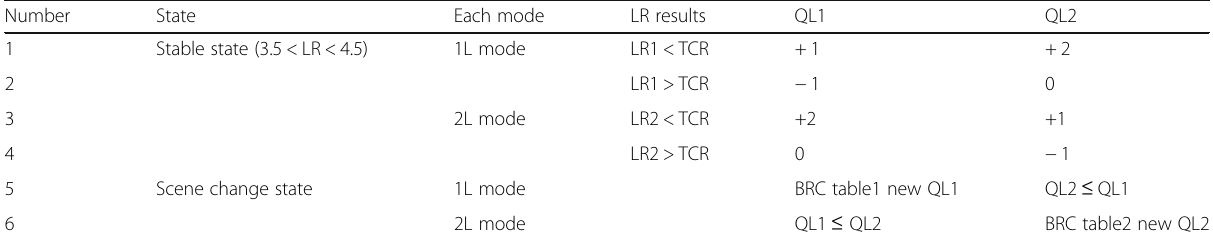
Table 2 Adjustment cases of the QLD process for 1L/2L BRC algorithm Number State